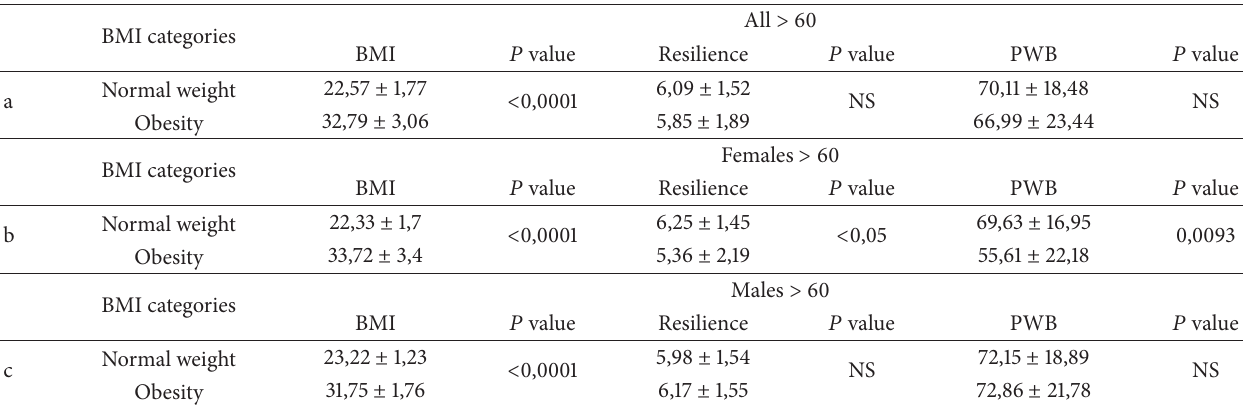
Table 2: Panel a : comparison of PWB and resilience scores between normal weight and obese all > 60 subjects. Results are reported as mean ± SD. 𝑃 value has been calculated by Student’s 𝑡 -test between each two groups. Panel b : comparison of PWB and resilience scores between normal weight and obese > 60 Females results are reported as mean ± SD. 𝑃 value has been calculated by Student’s 𝑡 -test between each two groups. Panel c : comparison of PWB and resilience scores between normal weight and obese > 60 males. Results are reported as mean ± SD. 𝑃 value has been calculated by Student’s 𝑡 -test between each two groups.